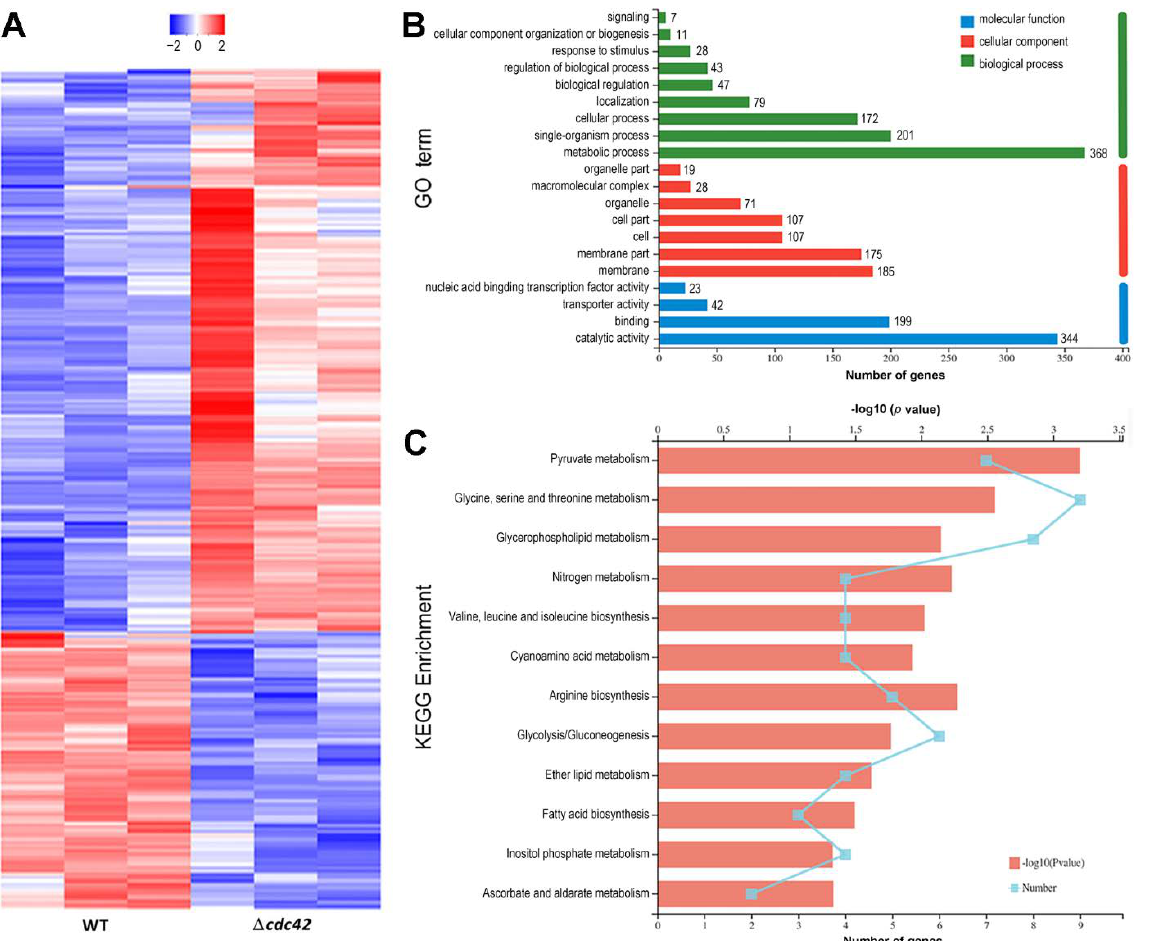
Figure 4. Transcriptomic analysis of Δ cdc42 versus WT strains in B. bassiana . ( A ) Heat map of differentially expressed genes (DEGs). ( B ) Counts of DEGs enriched to GO terms of three function classes. ( C ) Counts of DEGs enriched to KEGG pathways at different levels of p values.